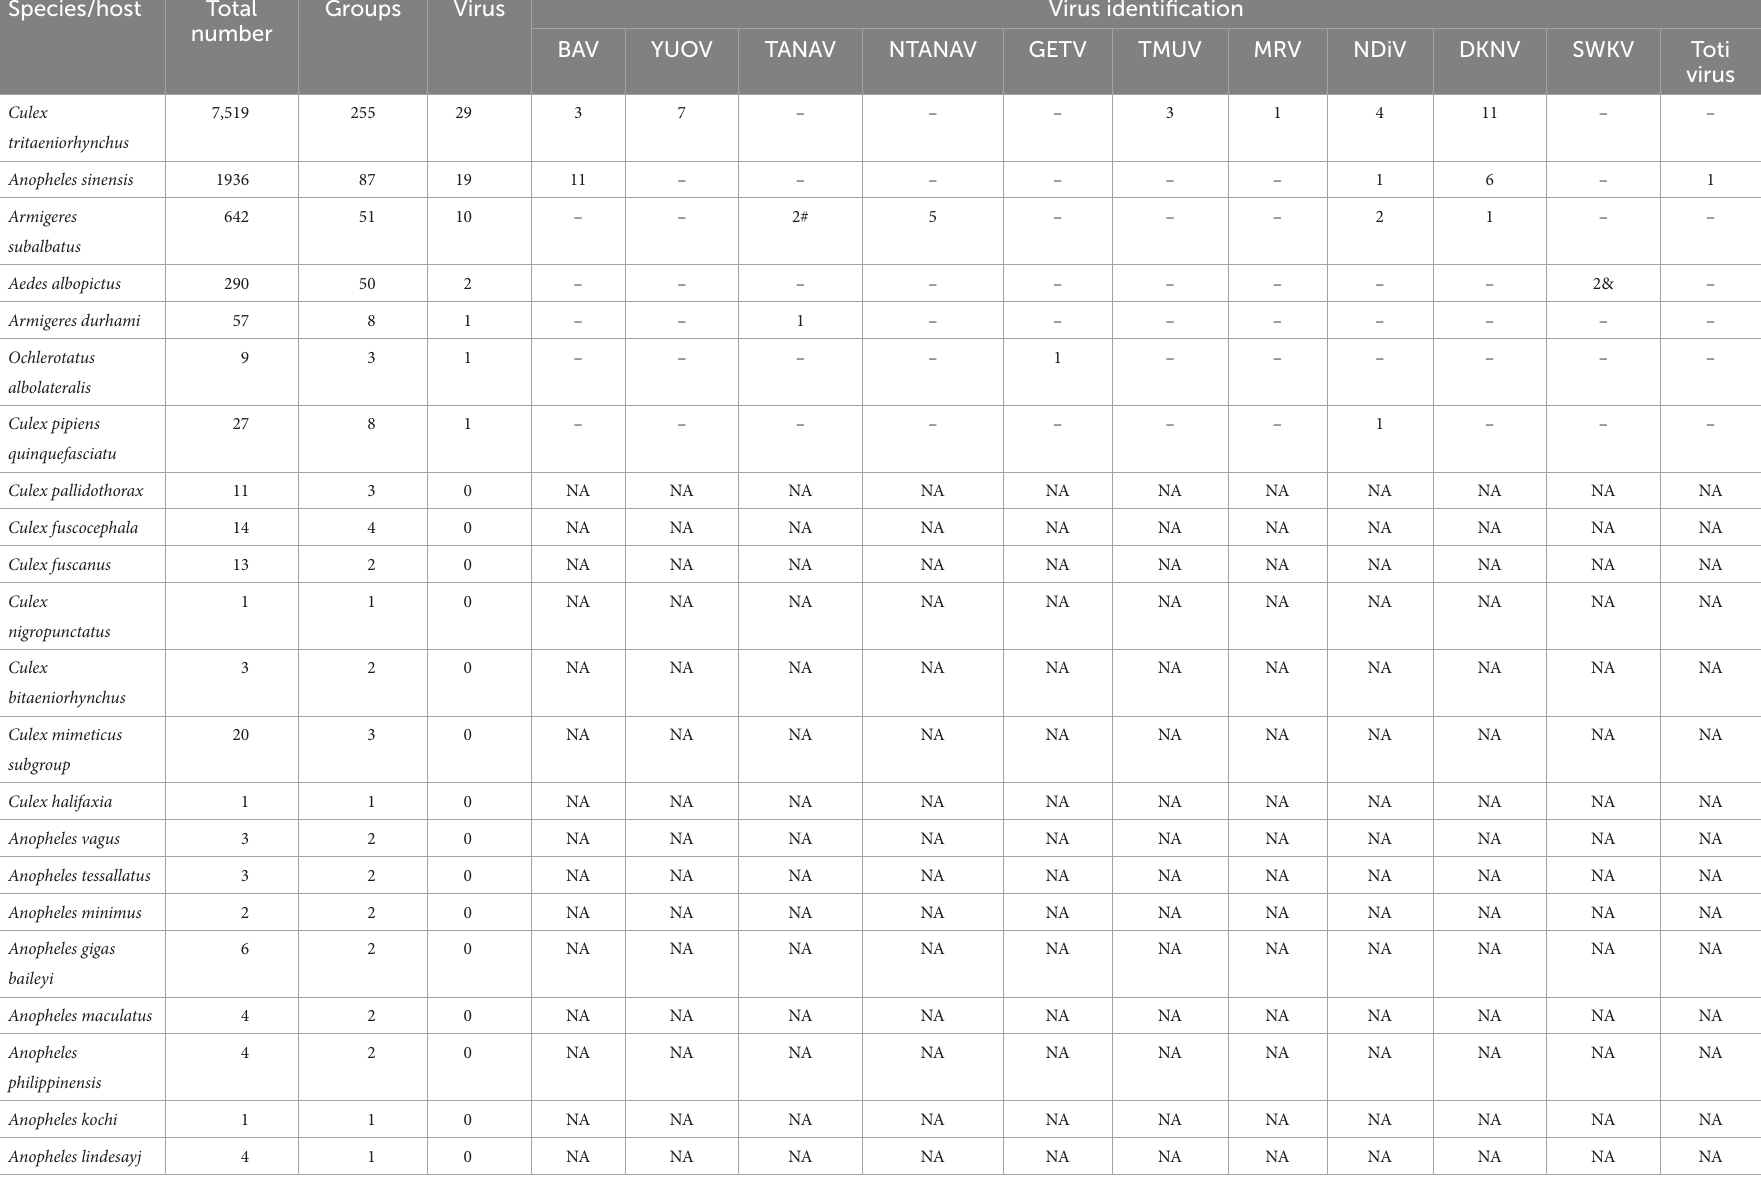
TABLE 2 Isolation of viruses from collected